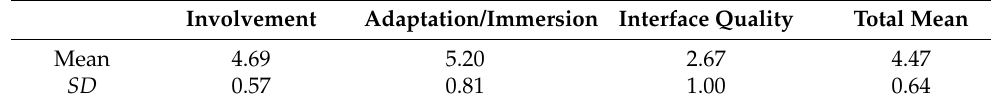
Table 6. Results of the Presence Questionnaire (1 (low presence)—7(high presence)).